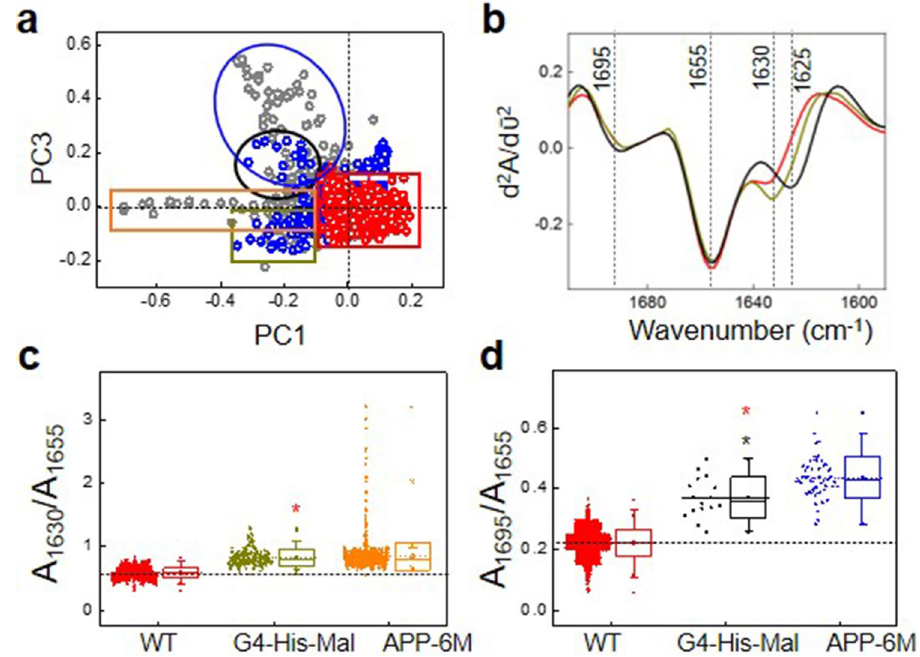
Figure 5. ( a ) Scores of the Principal component analysis (PCA) using the second derivative of the amide I region of infrared spectra showing data from WT mice, APP/PS1 mice 6 months old and APP/PS1 6 months old treated with G4-His-Mal dendrimers. WT data is shown in red, APP/PS1 data in grey and APP/PS1 treated with G4-His-Mal dendrimers in blue. The loadings corresponding to the PCA scores corresponding to the mice treated with G4-His-Mal- dendrimers are depicted in Fig. S1 together with the PCA scores of the whole set of data used in this study; ( b ) normalized mean second derivative of the amide I region calculated from the individual spectra of the data points within the colour circle/rectangle in the outlier regions of the PCA scores. The bottom row shows the box plot graphics depicting the absorbance ratio values corresponding to the two different types of aggregated species calculated from the second derivative spectra of the data points within the colour circle/rectangle in the outlier regions of the PCA scores. Fibrillary aggregates are shown in ( c ) and oligomeric/granular aggregates in ( d ). Boxplot shows the median (center line), interquartile range (IQR) (box); whiskers represent the most extreme data located no more than 1.5xIQR from the edge of the box, and outliers are the points outside this range. T-test is used for comparison with WT (red*) and 6 months mice (*black) at p < 0.002. Colour code: each set of point in the box plots has the same colour as the circle with which the data points from which the ratios have been marked in the scores plot. Unscrambler X software (CAMO, Oslo, Norway) was used to perform PCA and Origin 9.1 and Microsoft power point 2016 software were used for graphical